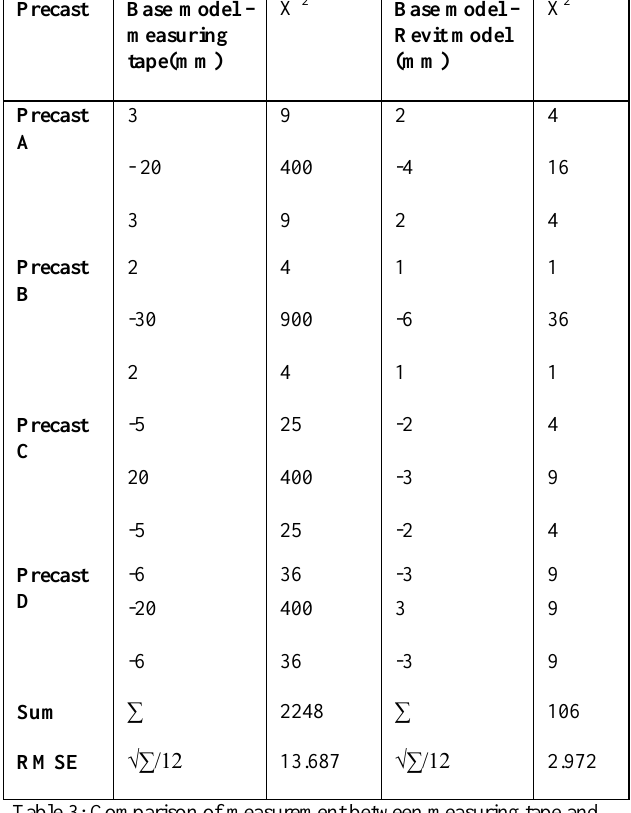
Table 3: Comparison of measurement between measuring tape and Revit model with the base